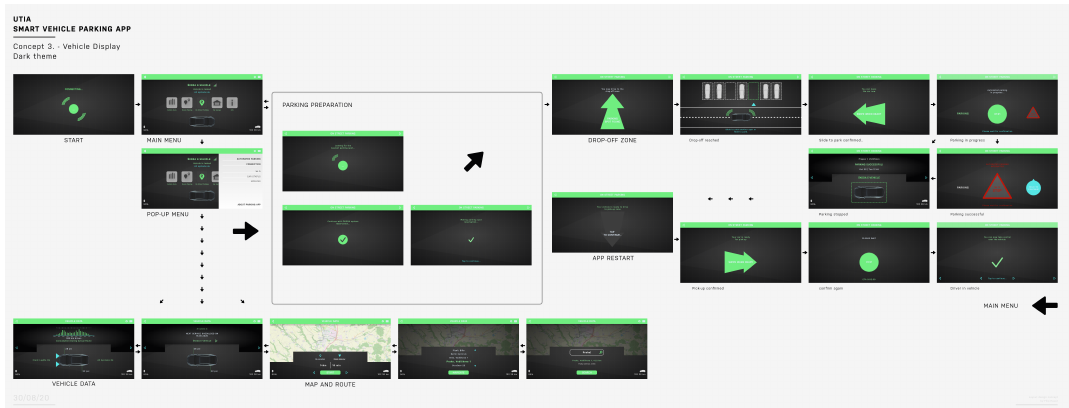
Figure 5. Vehicle main display human–machine interface.